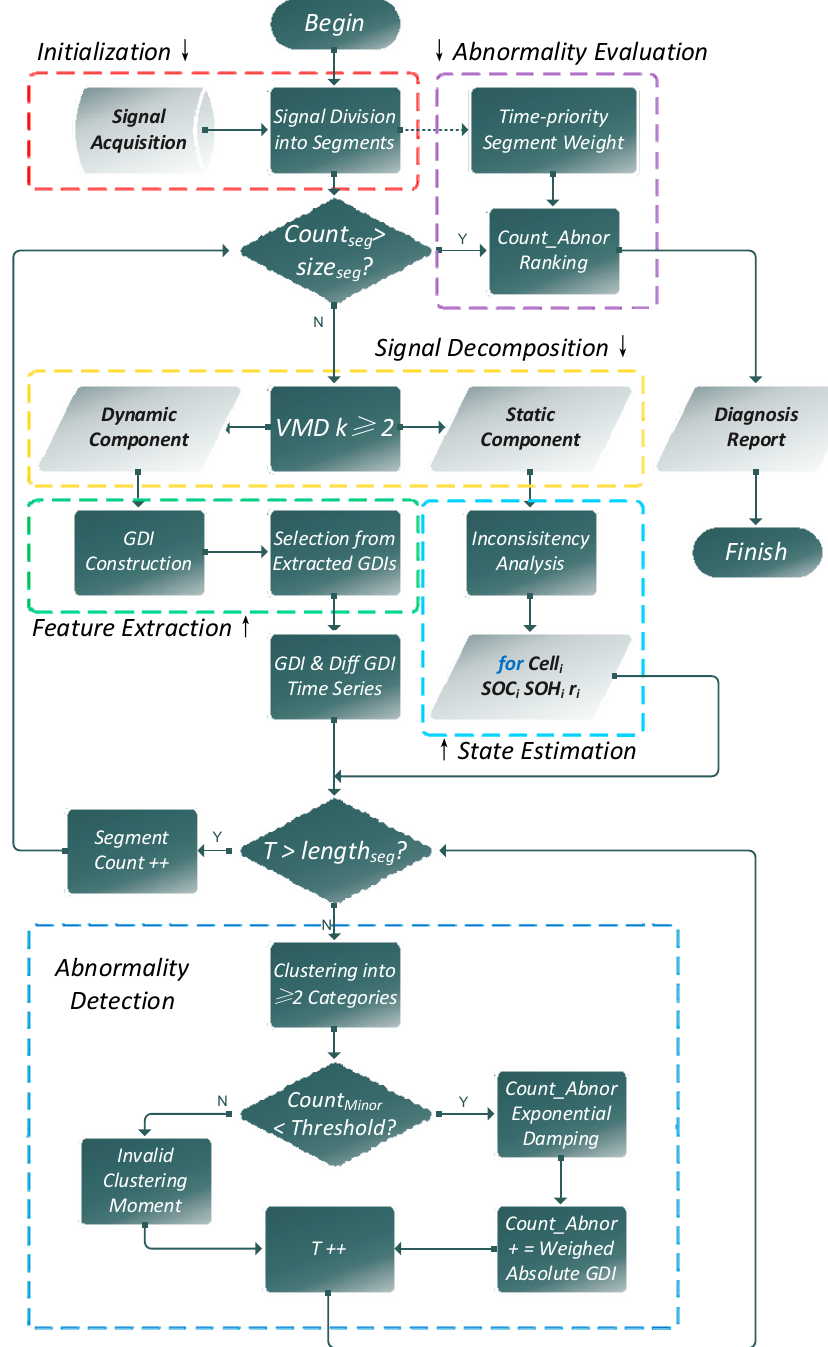
Figure 1. The overall flowchart of the proposed fault diagnosis